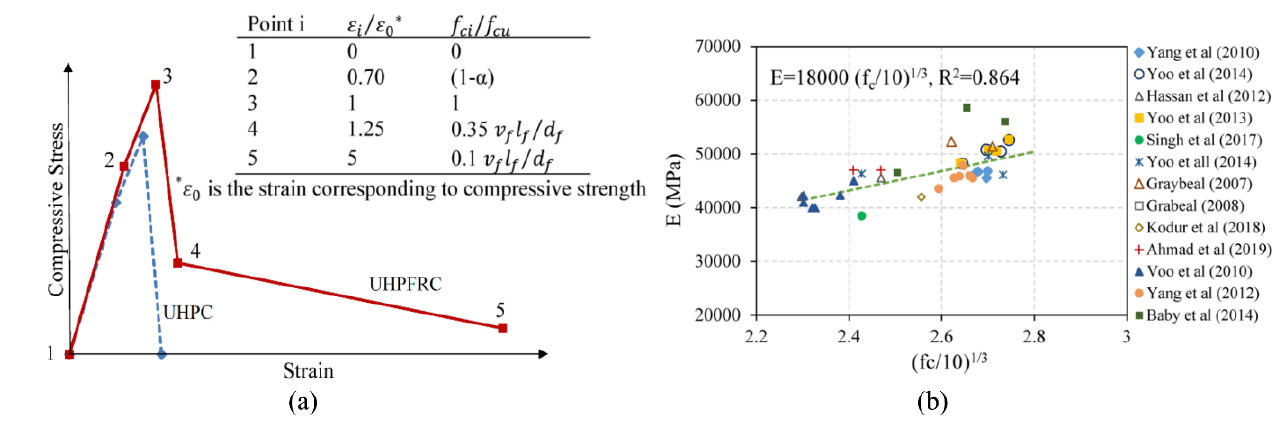
Figure 2. ( a ) Approximation for compressive stress–strain behavior of UHPC and UHPFRC. ( b ) Comparison of the proposed equation for elastic modulus with test results.